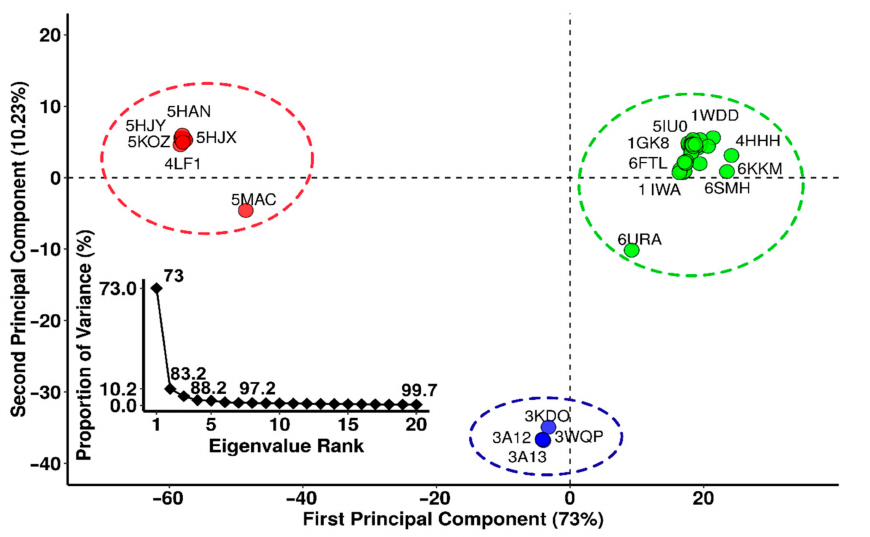
Figure 1. Principal component analysis (PCA) of RuBisCO RbcL isoforms. Green represents isoform I, red represents isoform II and isoform III is in